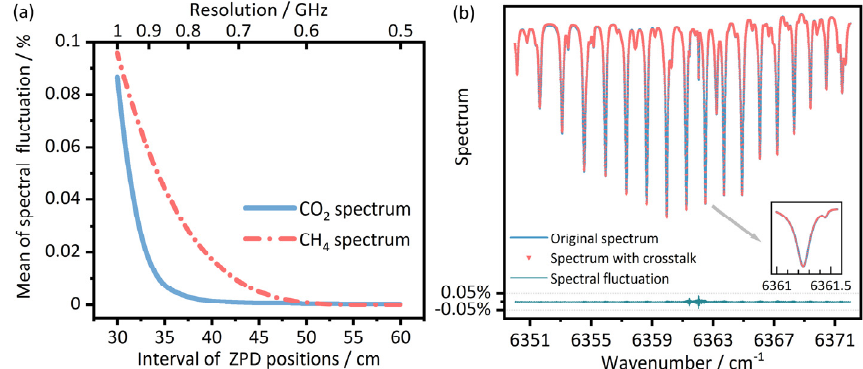
Figure 2. Results of the simulation for the crosstalk introduced by the superposition of IGMs. ( a ) The mean of spectral fluctuations after superposition at different ZPD position intervals. The upper horizontal axis represents the maximum resolution that can be achieved at different intervals. ( b ) A part of the CO 2 spectrum at a ZPD position interval corresponding to 1 GHz (0.033 cm − 1 ) resolution. The inset is a magnified view of the area where the spectrum has relatively large fluctuations.